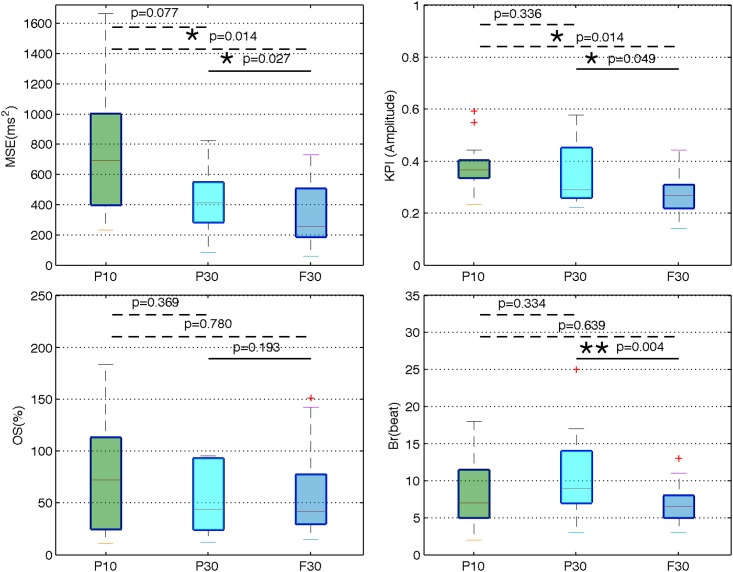
Performance indicators of three STM-based controllers.P10 is a partially-connected STM-based controller of N = 10 states, evaluated on 6 sheep for 13 different targets. P30 is a partially- connected STM-based controller of N = 30 states, evaluated on 7 sheep for 10 different targets. F30 is a fully-connected STM-based controller of N = 30 states evaluated on the same 7 sheep for the same 10 targets. The three controllers were used on sheep anesthetized by etomidate. Most of the sheep used in the experimental protocol P10 are different from the sheep used in the control tests of the P30 and F30 controllers. The sheep involved in the P30 and F30 protocols were the same. p-values are calculated between the three controllers. In the box plots, the dotted lines represent a Wilcoxon unpaired test and the solid line represents a Wilcoxon paired test. * denotes P < 0.05, and ** denotes P < 0.01.